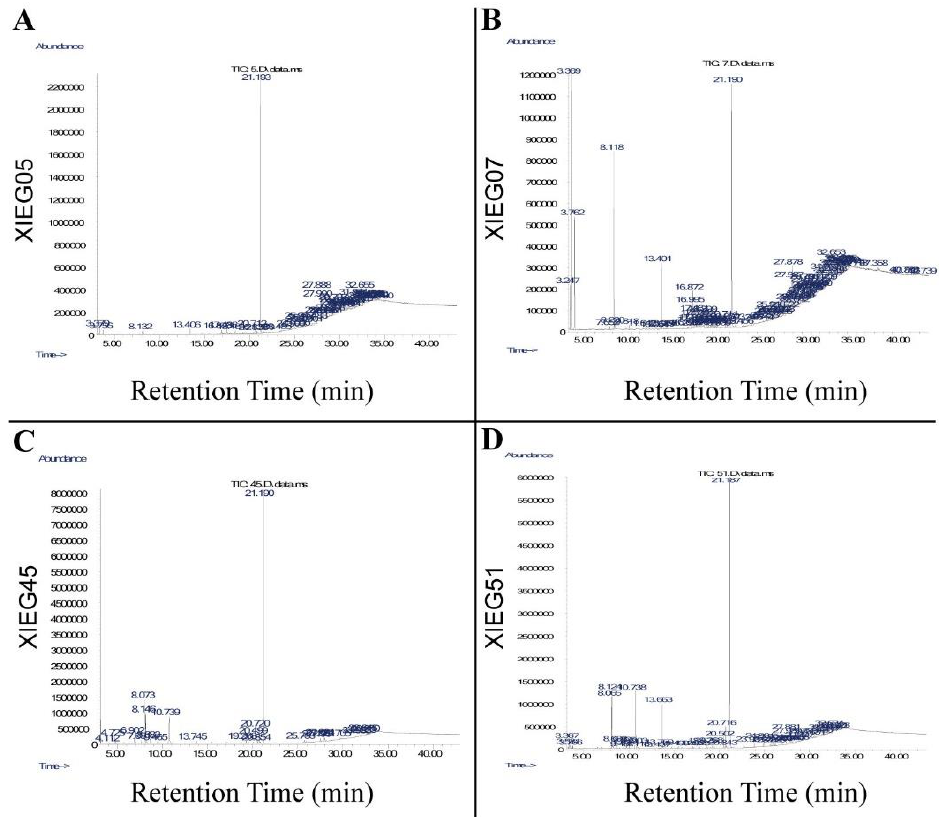
Figure 5 . GC-MS analysis of potential bioactive compounds in ethyl acetate extracts of cell superna- tant buffered of four co-cultures endophytic actinobacterial strains, ( A ) Saccharopolyspora gregorii (XIEG05), ( B ) Streptomyces enissocaesilis (XIEG07), ( C ) Nocardiopsis dassonvillei (XIEG45), and ( D ) Streptomyces luteus (XIEG51) with V. dahliae .